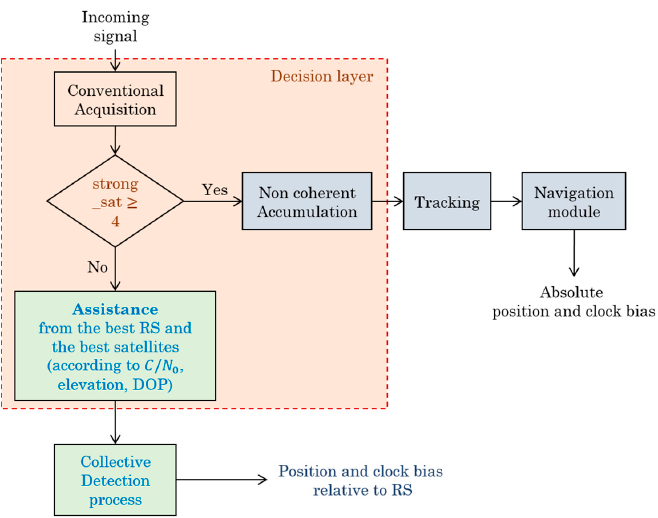
Figure 1. Smart functional architecture of a HS-SGR.